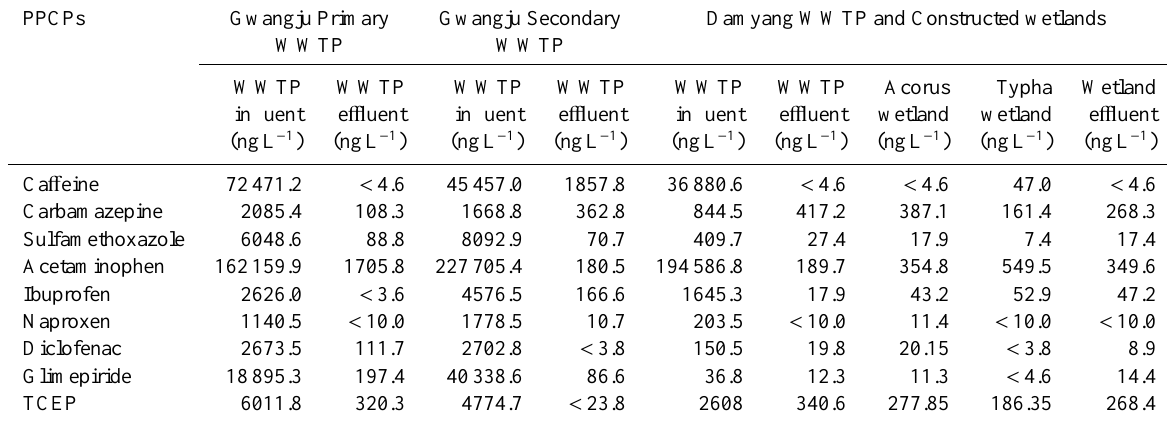
Table 3. Concentrations of selected PPCPs in WWTPs and